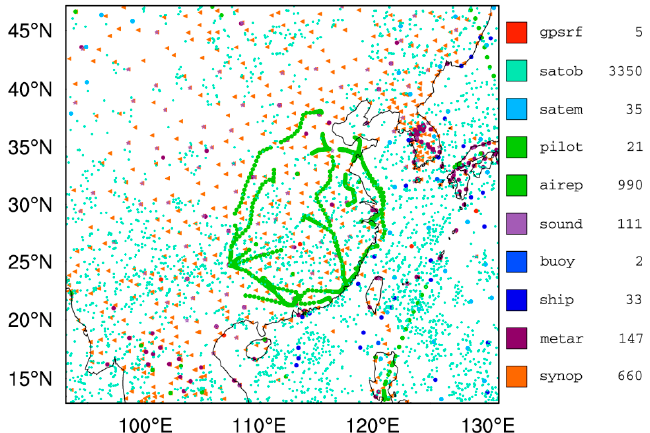
Figure 2. Conventional observations valid at 0000 UTC 05 July 2013.